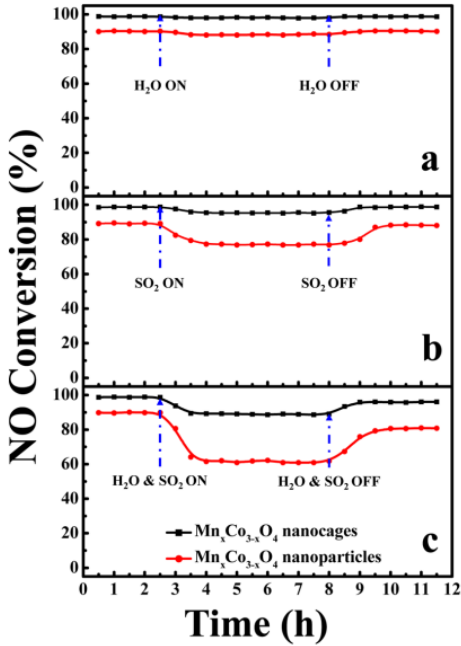
Figure 9. ( a ) H 2 O resistance, ( b ) SO 2 tolerance, and ( c ) H 2 O and SO 2 synergetic effect study of the catalysts at 175 ◦ C (Reaction conditions: [NO] = [NH 3 ] = 500 ppm, [O 2 ] = 3 vol %, [H 2 O] = 8 vol % (when used), [SO 2 ] = 200 ppm (when used), N 2 balance, and GHSV = 38,000 h − 1 ). (Reproduced with permission from Reference [29], Copyright 2014, American Chemical Society.).